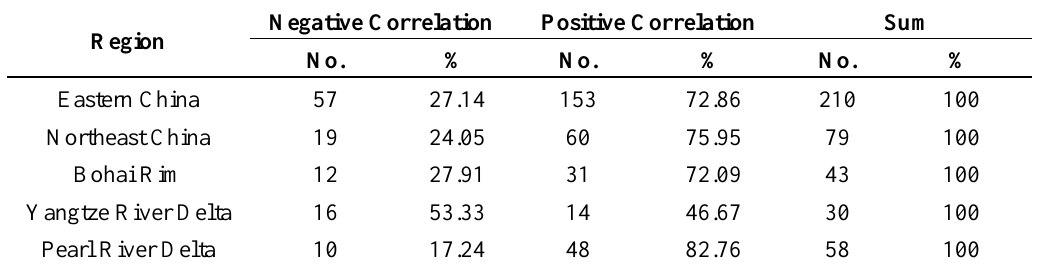
Figure 5. Spatial patterns of partial correlation coefficients between NDVI and temperature of meteorological stations in Eastern China. Table 3. Partial correlation coefficients between NDVI and temperature of meteorological stations in Eastern